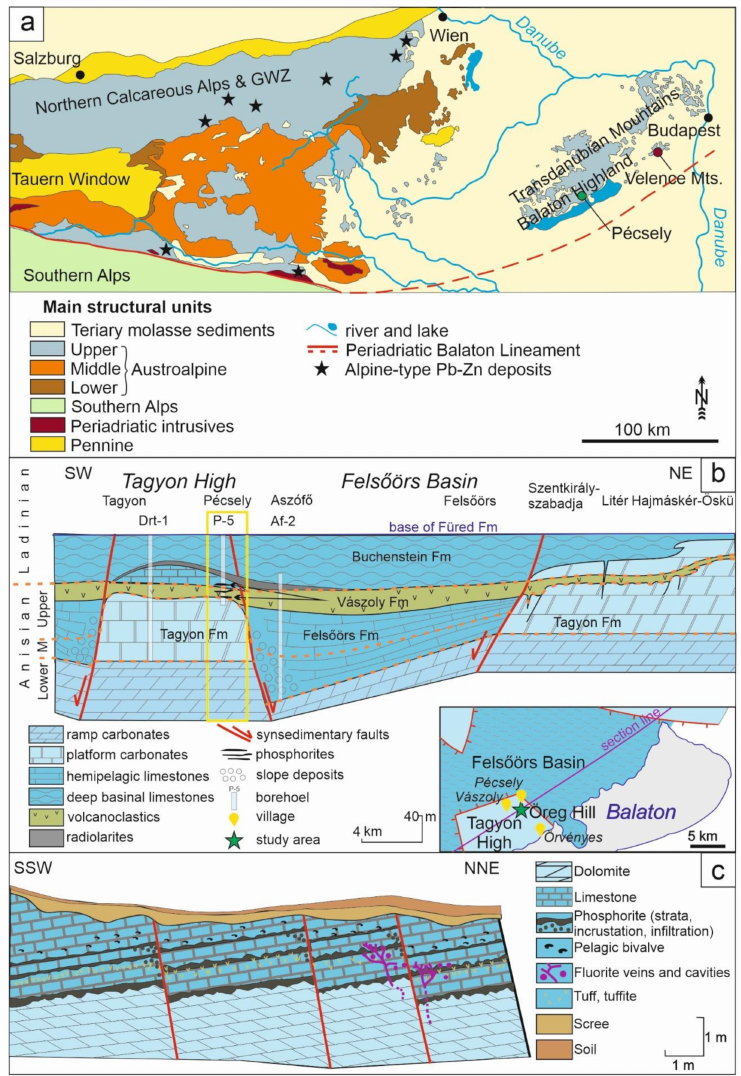
Figure 1. Location and geological structure of the study area. ( a ) Major structural units of the Eastern Alps—Pannonian Basin region (modified after [18]) with the positions of major Pb-Zn deposits; ( b ) facies arrangement of Middle Triassic Formations along the strike of the Balaton Highland [16]. The formations found in the area of P é csely are marked with a yellow rectangle; ( c ) schematic geological section of the P é csely-11 exploration trench (modified after